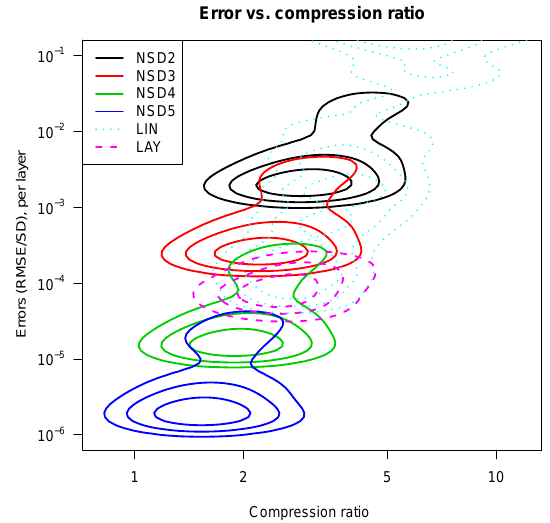
Figure 2. The relationship between normalized errors and compres- sion ratio for the lossy compression methods considered. The three contours for each method show the bounds within which the two- dimensional kernel-smoothed distribution integrates to 0.25, 0.5 and 0.75, respectively. Only dense variables were used to produce this plot. The normalized errors (the y -axis coordinate) were measured per layer and then